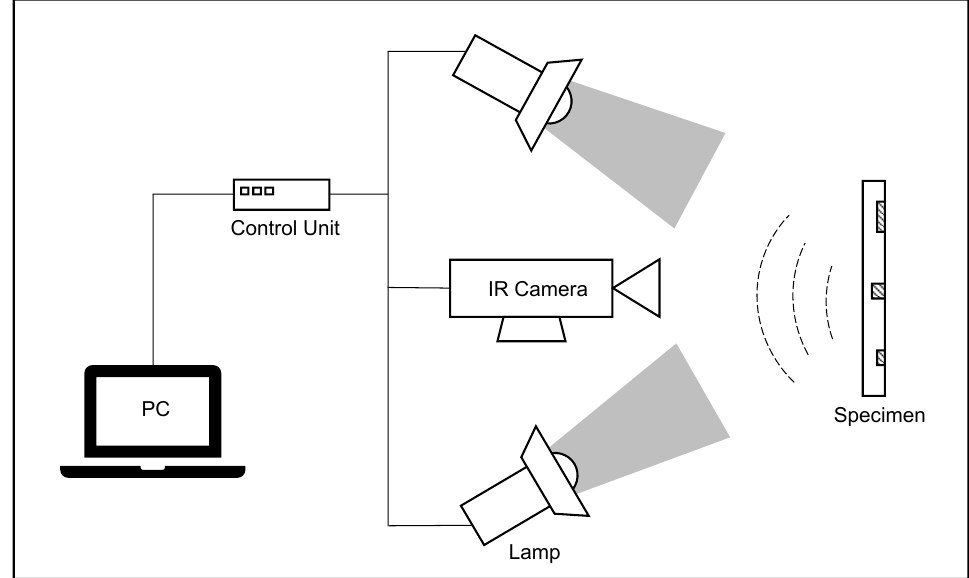
Figure 4. Setup of the PT